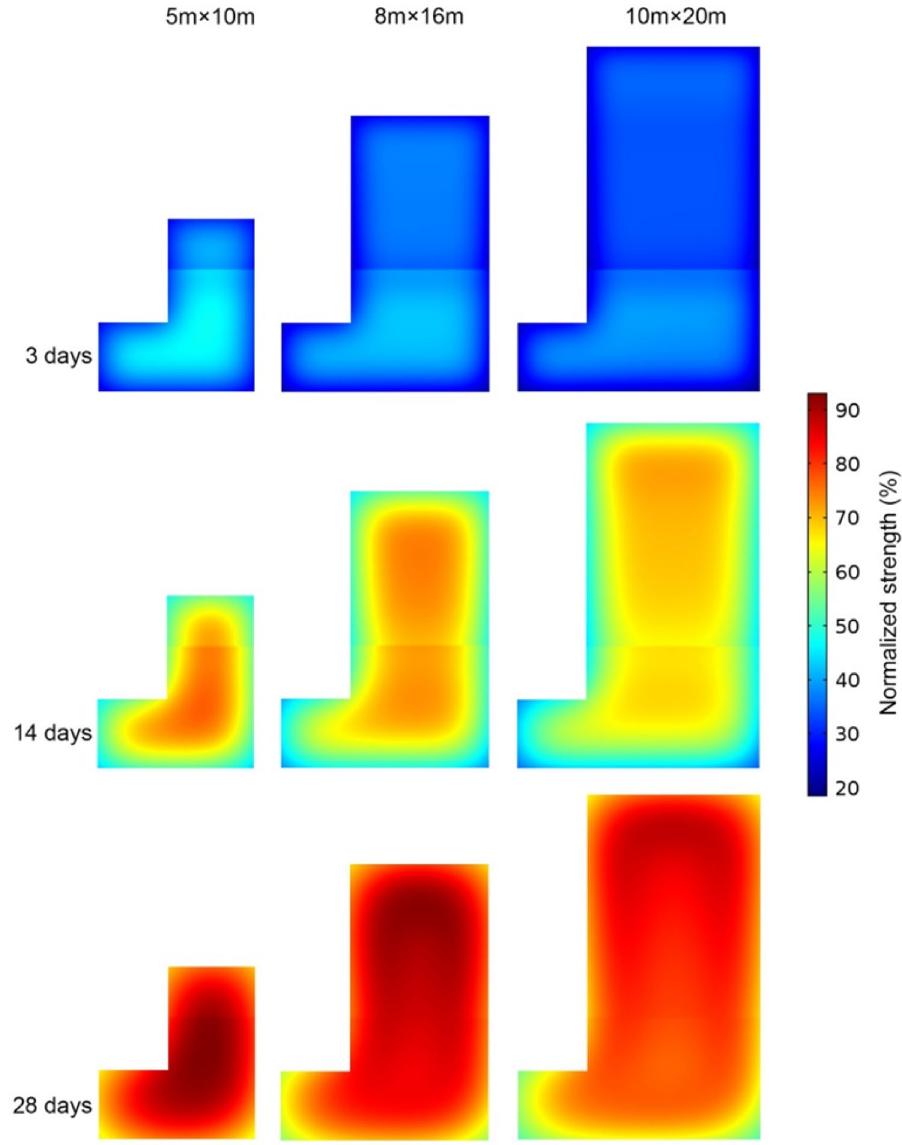
Fig. 16 Effect of stope size on spatial distribution of the strength of CPB with lower binder content (Cement content 60.358 kg/m 3 i.e., 4.5 wt%).